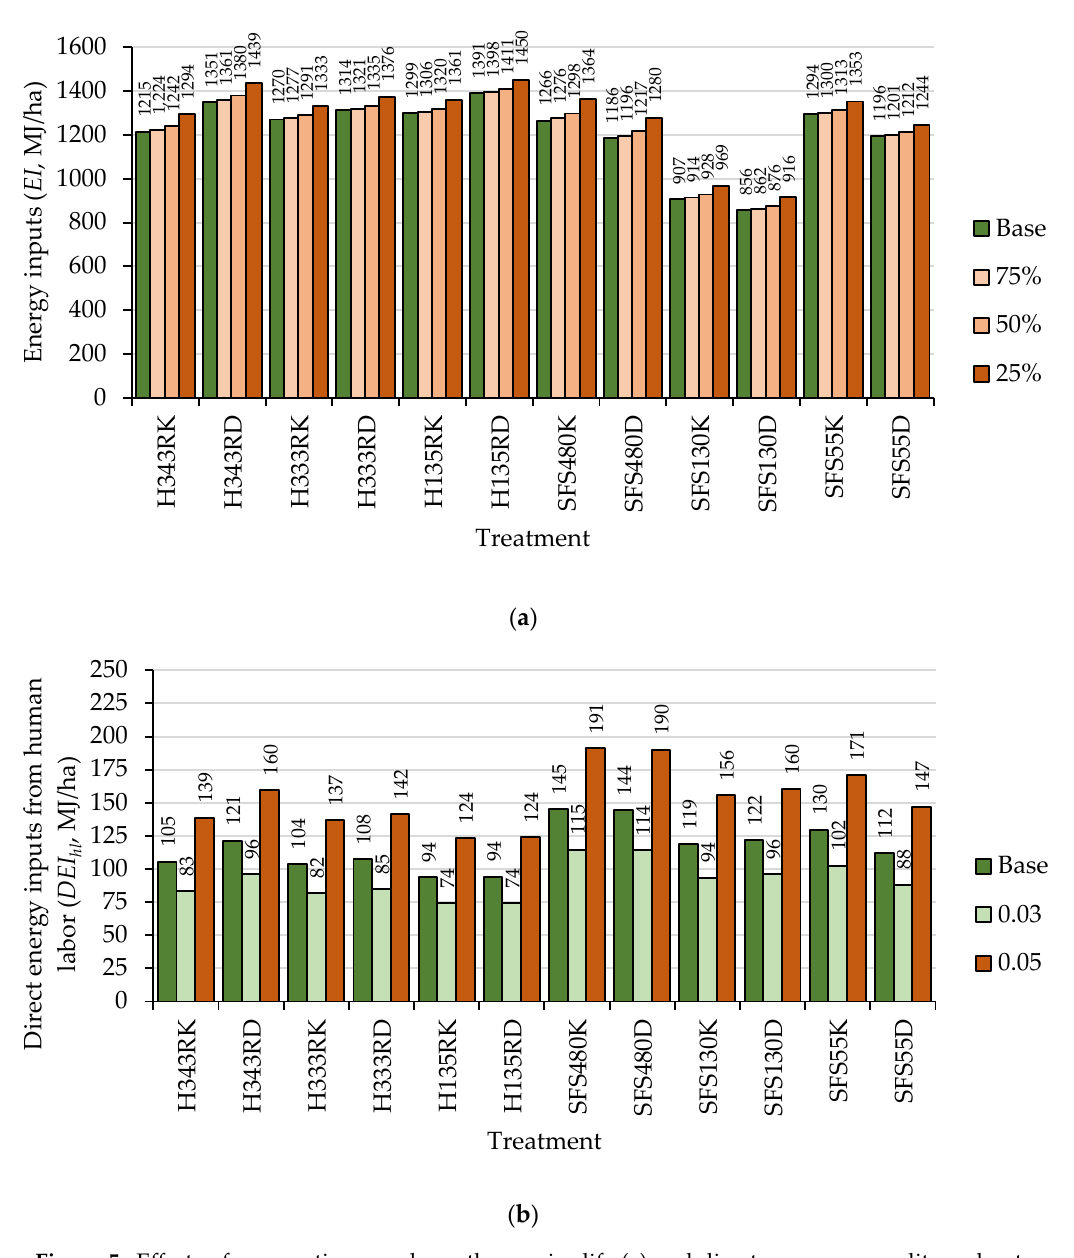
Figure 5. Effects of assumptions made on the service life ( a ) and direct energy expenditure due to human labor ( b ). Legend: Base—results obtained based on the assumptions of this study—“base scenario”, 75%—results obtained based on a reduction of service life by 25%, 50%—results obtained based on a reduction of service life by 50%, 25%—results obtained based on a reduction of service life by 75%, 0.03—results obtained based on a human energy expenditure of 0.03 MJ/min, 0.05—results obtained based on a human energy expenditure of 0.05 MJ/min.